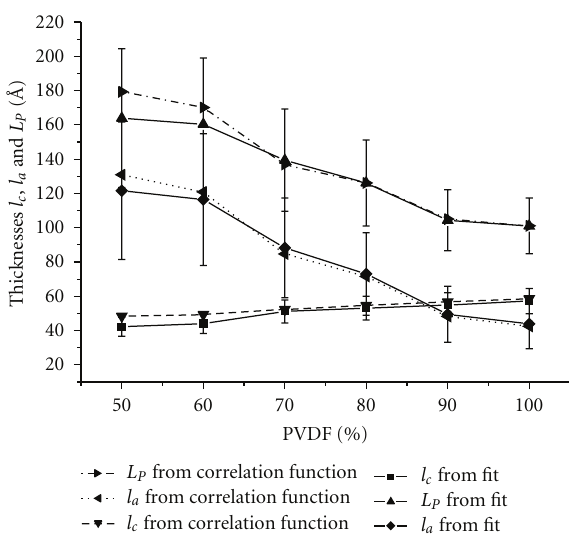
Figure 2: Thickness, l c , of the crystalline lamellae, thickness of the amorphous layers, l a and average long period, L p , deduced from linear correlation function γ ( r ) and curve-fitting.